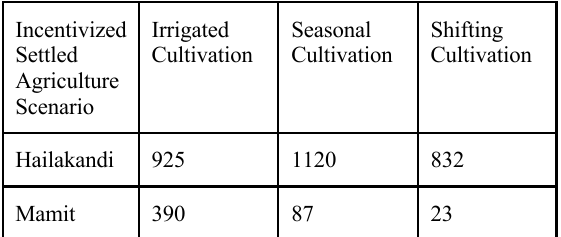
Table 5. Number of land parcels of 25 ha each under various forms of land use in the incentivized settled agriculture scenario